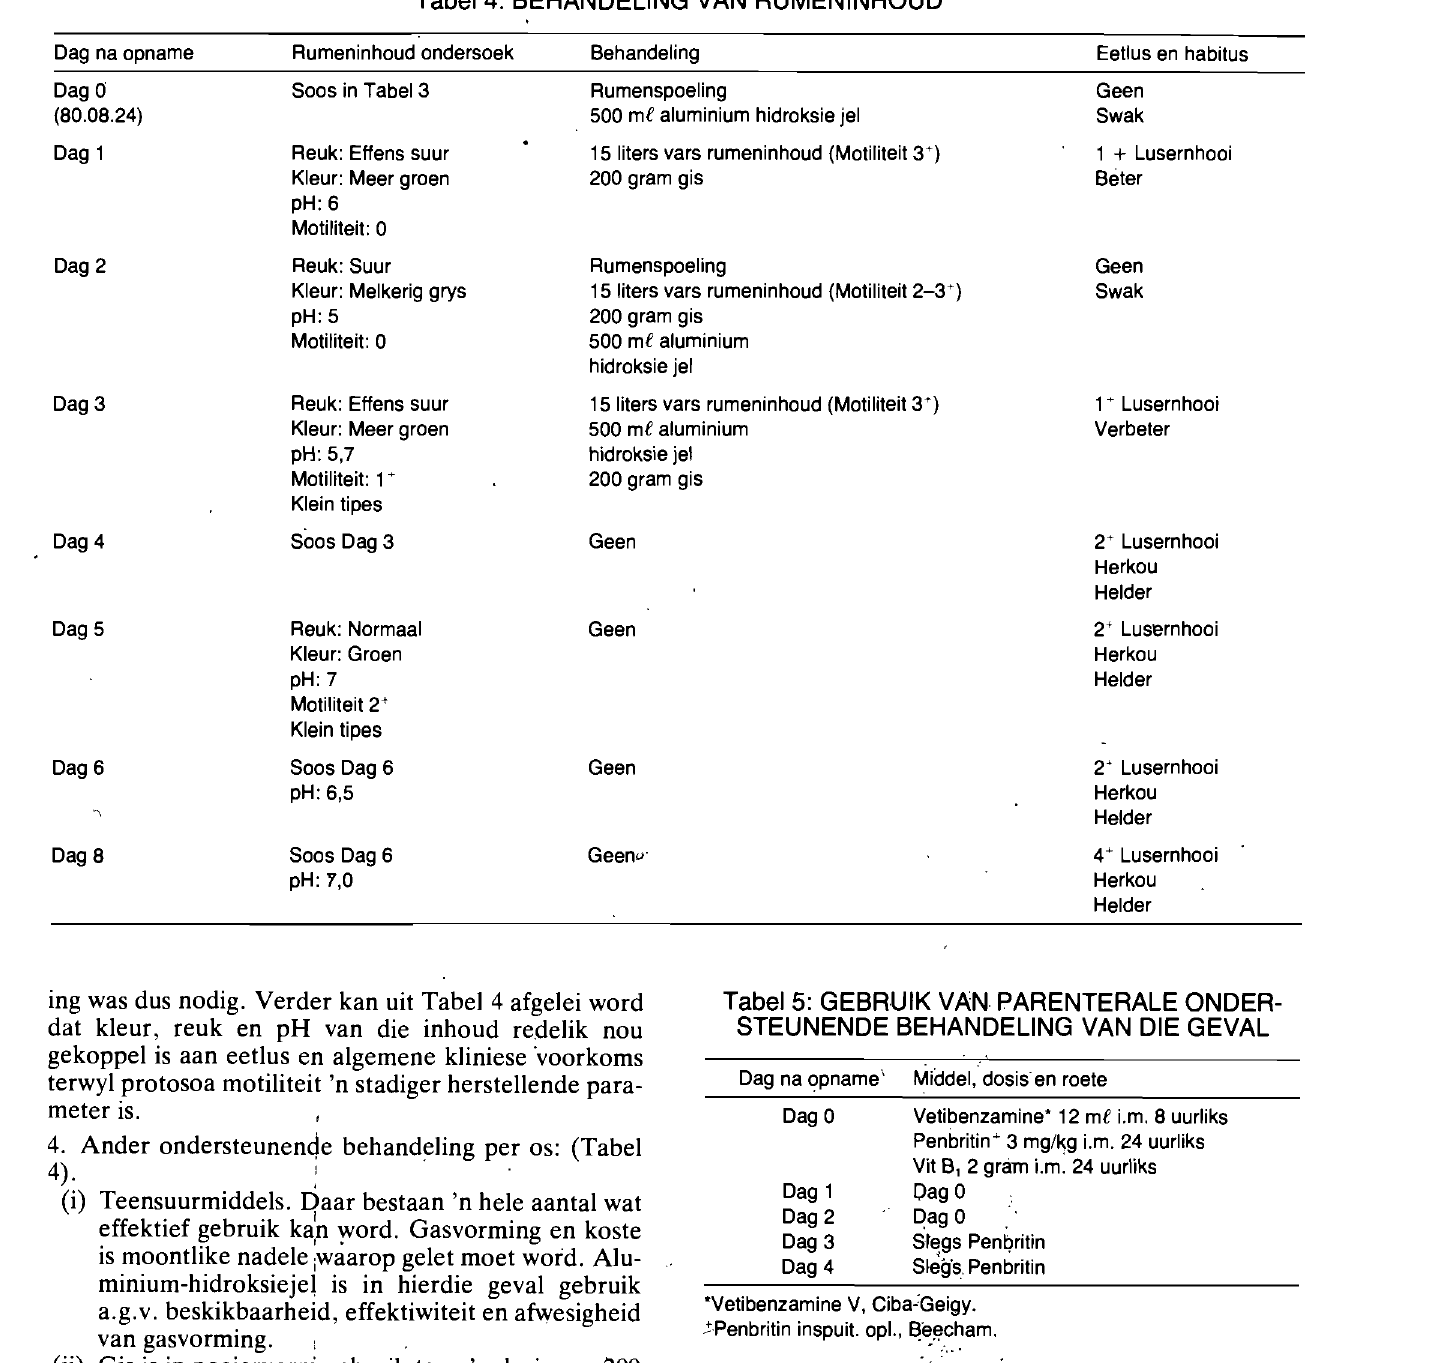
Tabel 5: GEBRUIK VAN. PARENTERALE ONDER STEUNENDE BEHAN DE LING VAN DIE GEVAL